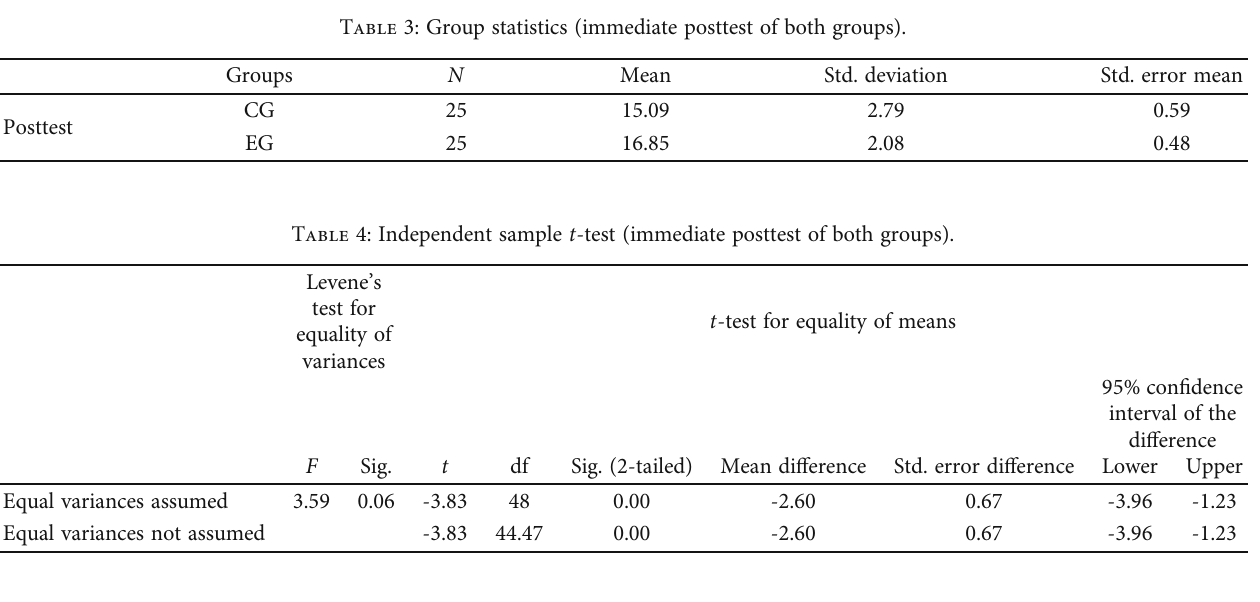
Table 5: Paired sample test (pretests and immediate posttests of both groups).